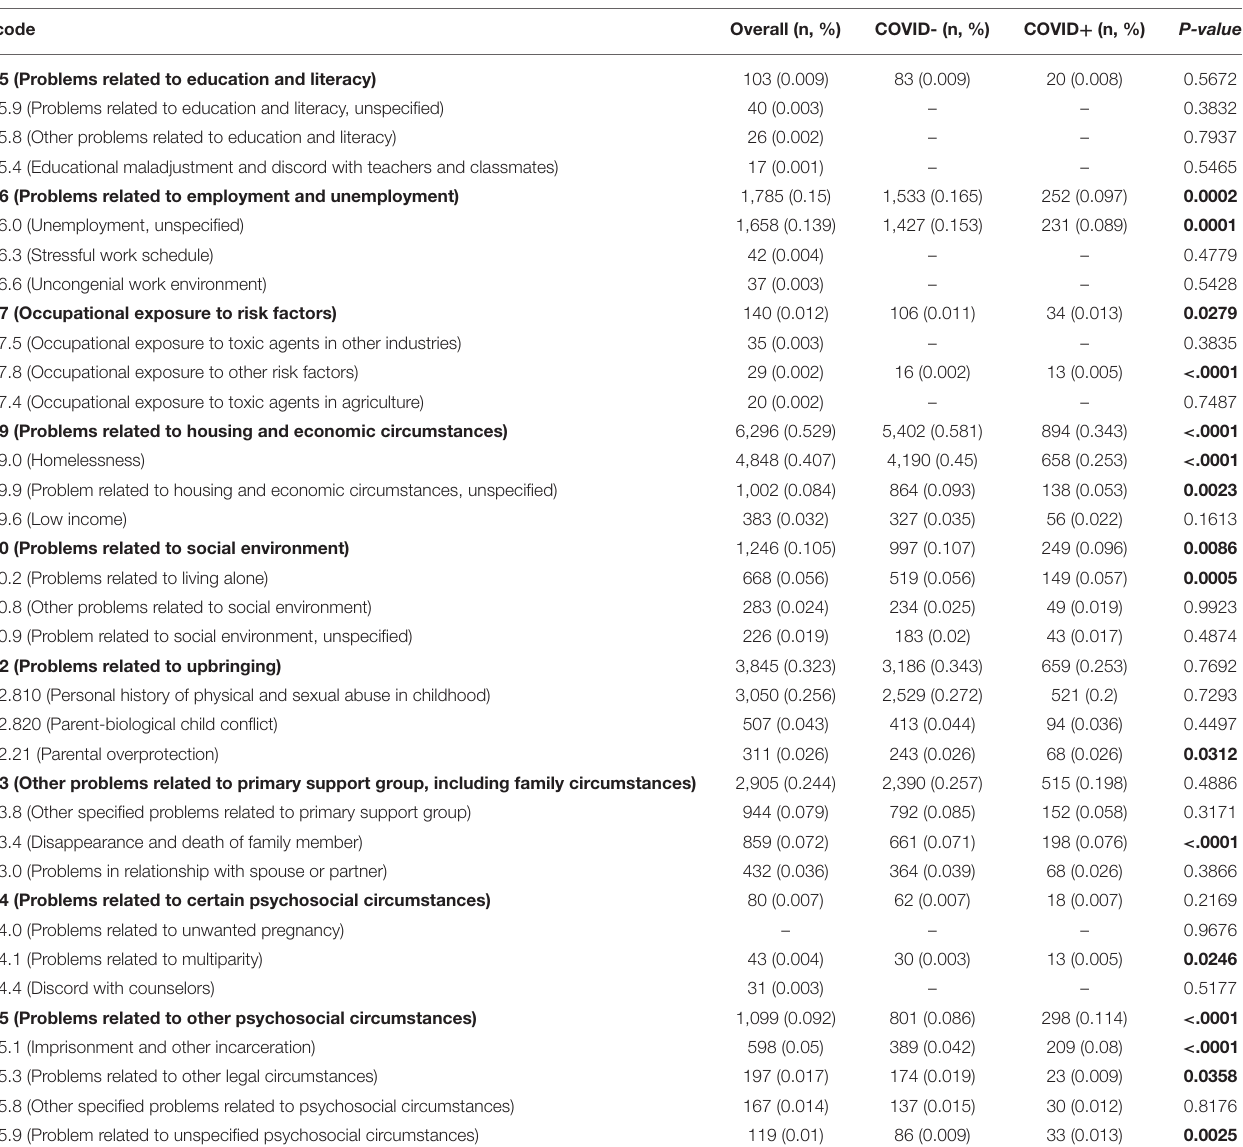
TABLE 1 | Most commonly used Z codes: Overall and by covid-19 status. Z